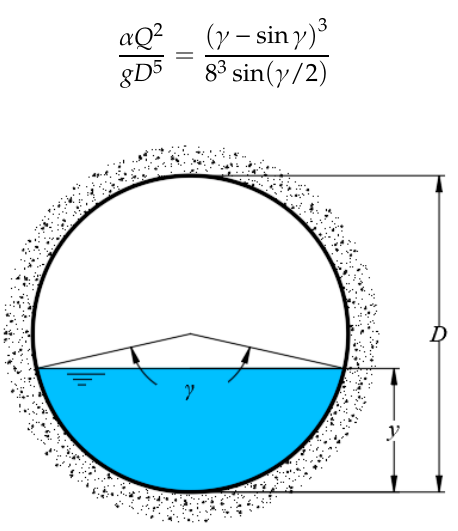
Figure 1. Cross-section of a circular conduit.